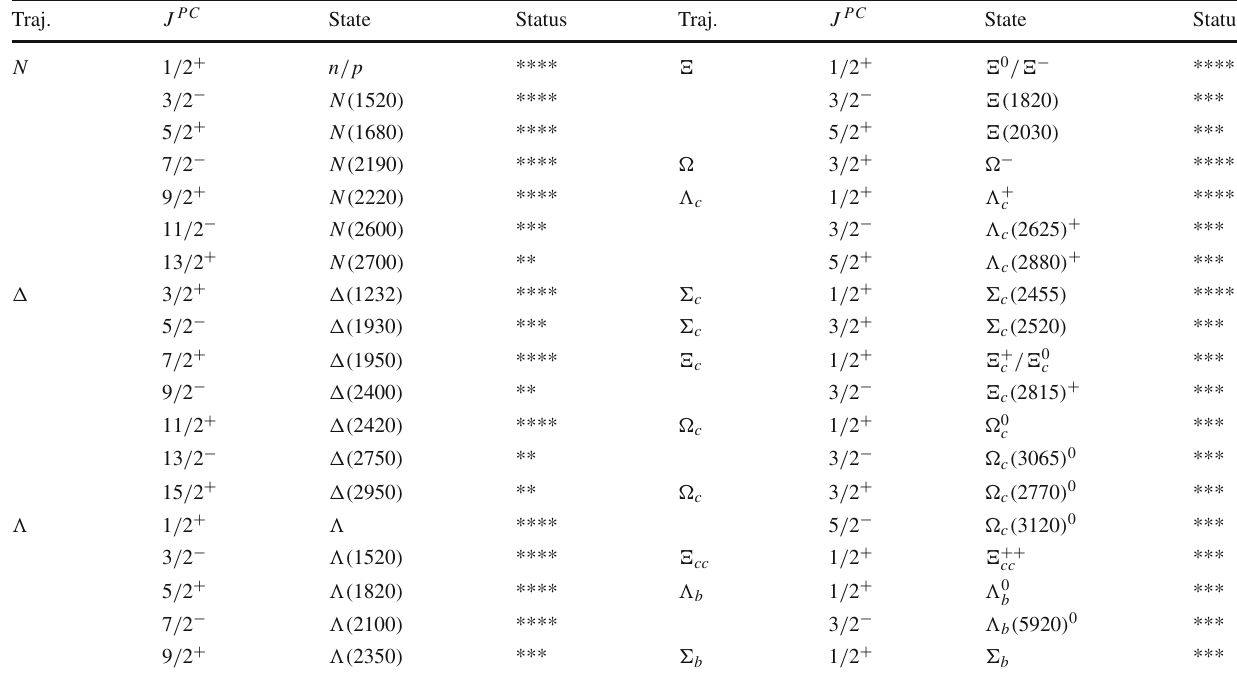
Table 18 All the baryon states on the orbital leading Regge trajec- tories used in our fits, or chosen as heads of trajectories where no excited states are identified. All fitted trajectories have the same slope,